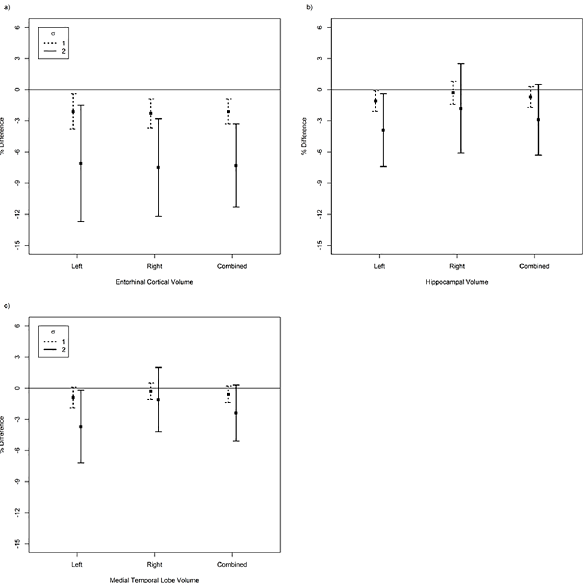
Fig 2. A-C. Adjusted mean volume differences (95% CI) of smaller brain regions per differences in plasma clusterin levels. Volumes differences in brain regions estimated for plasma clusterin 1 and 2 SD ( σ ) above mean plasma clusterin, relative to volumes in subjects with mean plasma clusterin. Differences in volume measures were estimated for left, right, and combined left and right entorhinal cortex (a), hippocampus (b), and medial temporal lobe (c).